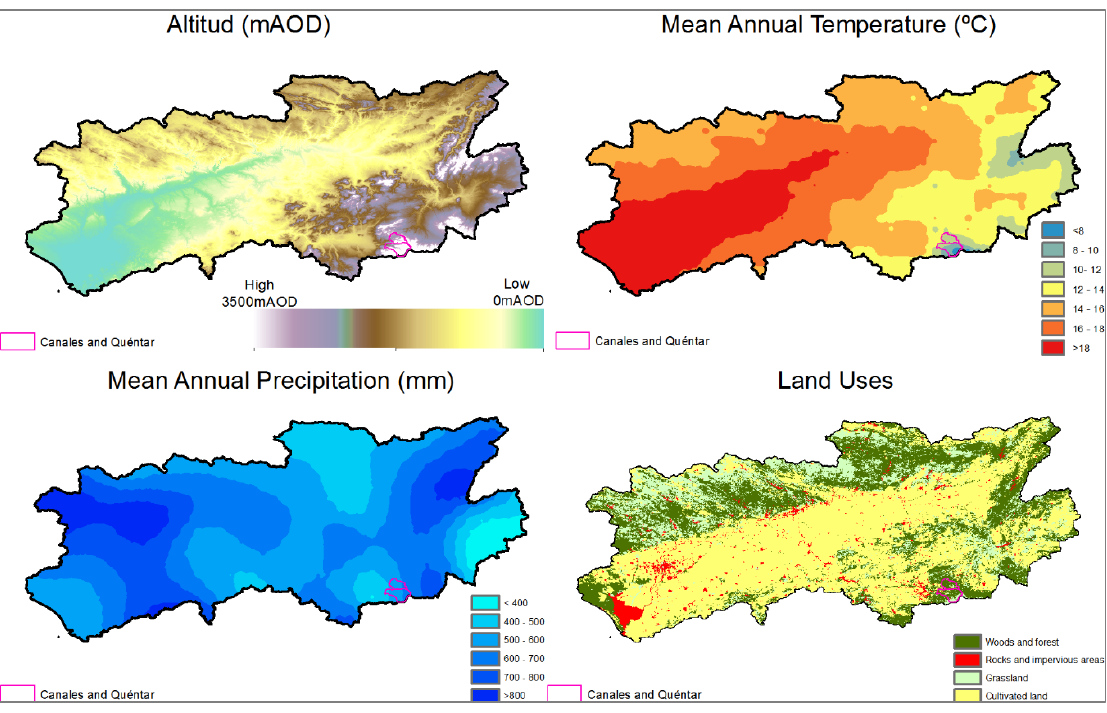
Figure 3 . Guadalquivir River Basin ( a ) altitude, ( b ) mean annual temperature, c ) mean annual Figure 3. Guadalquivir River Basin ( a ) altitude, ( b ) mean annual temperature, ( c ) mean annual precipitation, precipitation, and ( d ) land uses. and ( d ) land